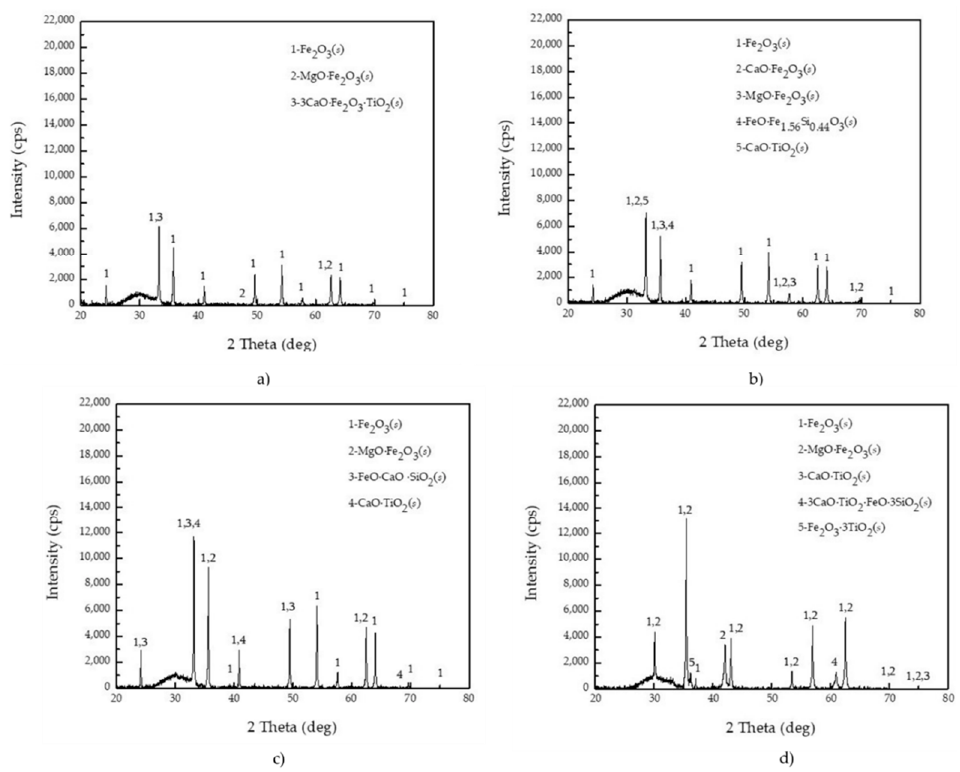
Figure 5. XRD results of Blend 2 sintered at: ( a ) 1373 K; ( b ) 1423 K; ( c ) 1473 K; and ( d ) 1523 K .